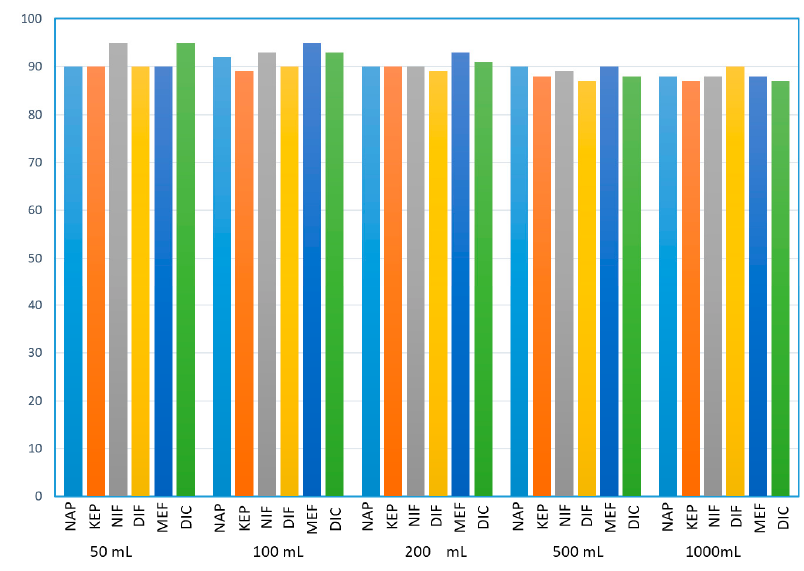
Figure 7. E ff ects of sample volume on the recoveries (%) of selected pharmaceuticals, n = 3. Figure 7. Effects of sample volume on the recoveries (%) of selected pharmaceuticals, n = 3.